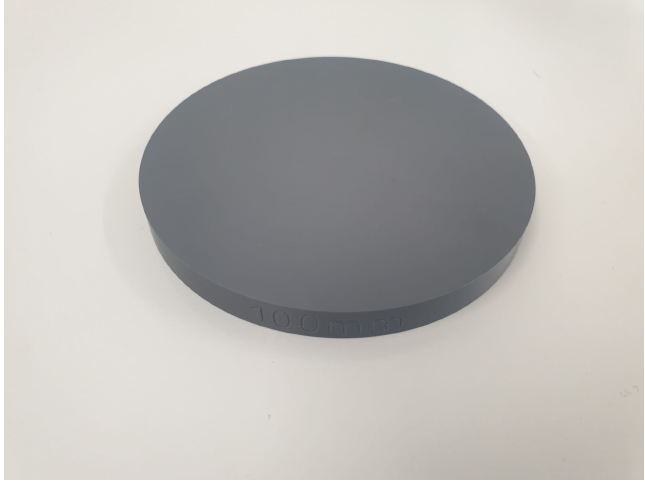
Figure 6. Calibration disk (radius/width: 100 mm/10